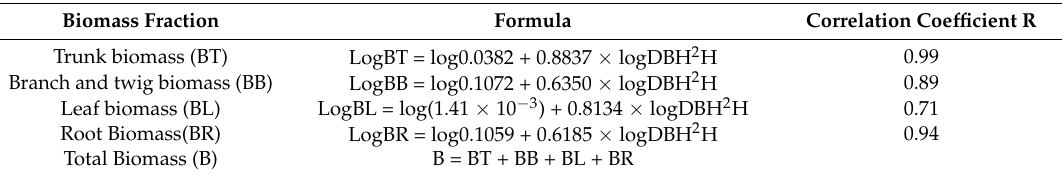
Table 1. Formulas of Chen and Li [33] for the relationship between the diameter at breast height (DBH) in centimeters, the tree height (H) in meters, and the biomass in